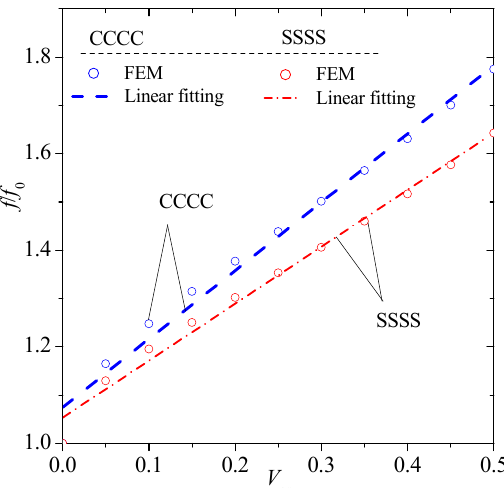
Figure 8. Average effect of graphene on natural frequency of the composite plate of graphene for Figure 8. Average e ff ect of graphene on natural frequency of the composite plate of graphene for CCCC, and SSSS boundary CCCC, and SSSS boundary conditions.